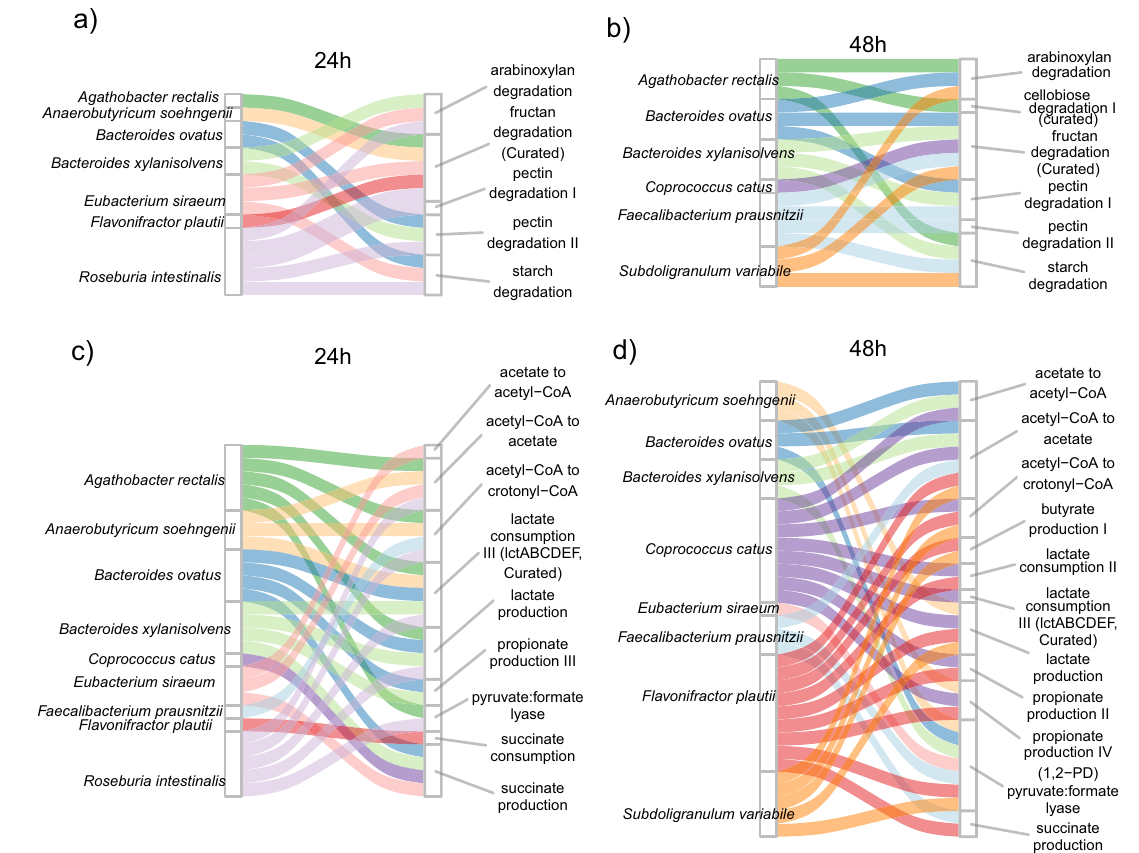
Fig. 5 Species-function linkage based on transcriptional activity. Species showing active transcription of carbohydrate degradation modules at a 24 h and b 48 h. Species showing active transcription of volatile fatty acid metabolism at c 24 h and d 48 xylanisolvens (0.0). (Supplementary Fig. 8c, d). Minor to no differences in competition and complementarity was observed for other strains which are phylogenetically more unrelated and belong to different genera. Notably, F.prausnitzii had lower competition predicted from gene expression data with S. variabile and R. intestinalis compared to genome-based prediction. Based on genome, F.prausnitzii had higher complementarity with the two Bacteroides strains (0.167), while based on gene expression data, it had 0.17 with B.ovatus and 0.08 with B.xylanisolvens . Based on genome, A.soehngenii had complementarity of 0.2 with the B. xylanisolvens strains but based on transcriptomics it was 0.114. These results highlight the need for caution when predicting pairwise interactions solely based on genomic content and the need for taking into account functional measurements such as metatranscriptomic or metaproteomes. For disentangling active metabolic processes at the strain-level, transcriptomic pro fi les were analysed using the gut metabolic modules (GMMs) framework. The GMMs reported previously were curated to include modules based on physiological information of the ten Db-MM strains (see methods for curation steps) 11 . Differences with respect to active expression of metabolic modules in the different strains were observed between the 24 h and 48 h samples (Fig. 5a, b). At 24 h, R. intestinalis , B.ovatus, B.xylanisolvens, E.siraeum , and A.rectalis were actively involved in expressing modules for fi bre degradation. Conversely, at 48 h, R. intestinalis did not show any expression for modules for fi bre degradation or organic acid metabolism (Fig. 5b). Both C.catus and S.variabile showed gene expression for fructan degradation, and S.variabile also showed gene expression starch and arabinoxylan degradation modules (Fig. 5b). For organic acid